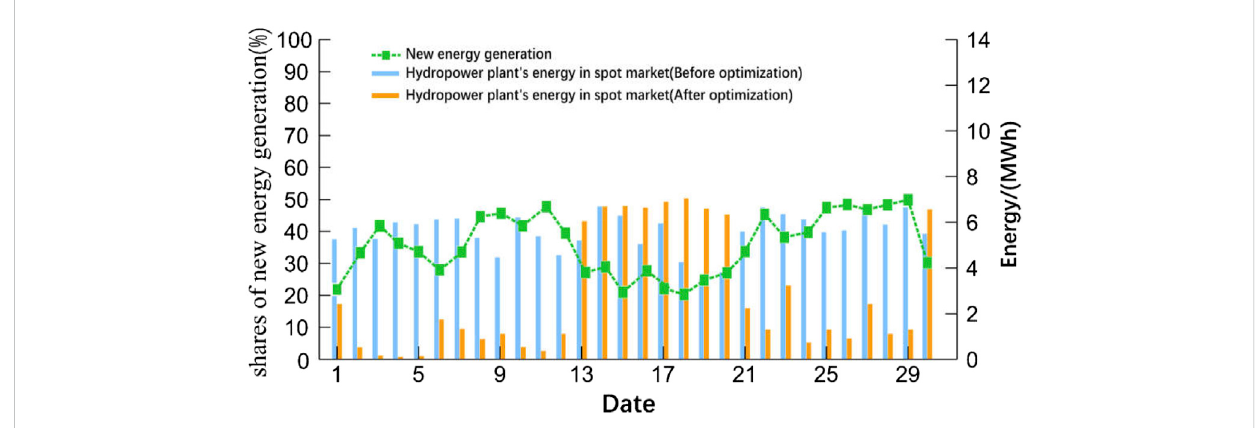
FIGURE 10 Hydropower plant ’ s energy allocation before and after